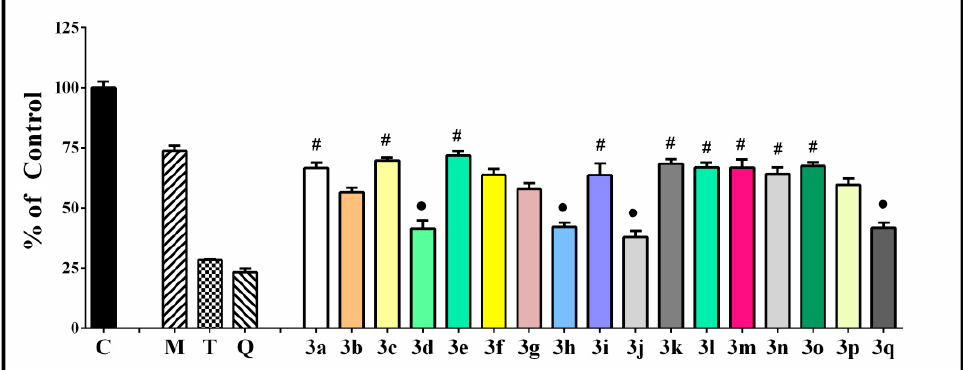
Figure 6. Effect of the tested hydrazone derivatives [90 μ mol/L] on the in vitro Fe(II) induced oxidative damage in the lecithin containing model system [1 mg/mL]. Melatonin, Trolox, and Quercetin (labeled with M, T, and Q, respectively) have been used as reference compounds at the same concentrations. All data are expressed as Mean ± SEM. The effect of compounds labeled with ● is considered statistically identical ( p < 0.05) compared with the effect of Compound 3a (containing the residue of unsubstituted benzaldehyde). Analogically with #, we labeled the compounds with an effect statistically identical ( p < 0.05) to 3d .